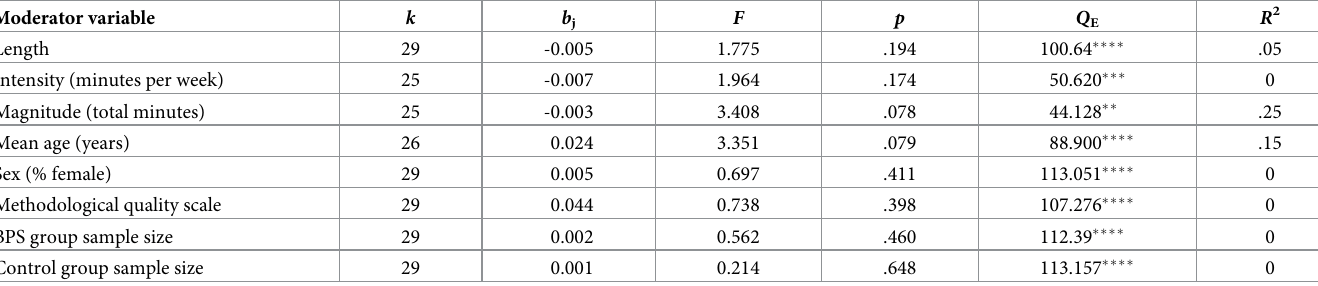
Table 5. Results of the simple meta-regressions of continuous moderator variables on the effect sizes for wellbeing.